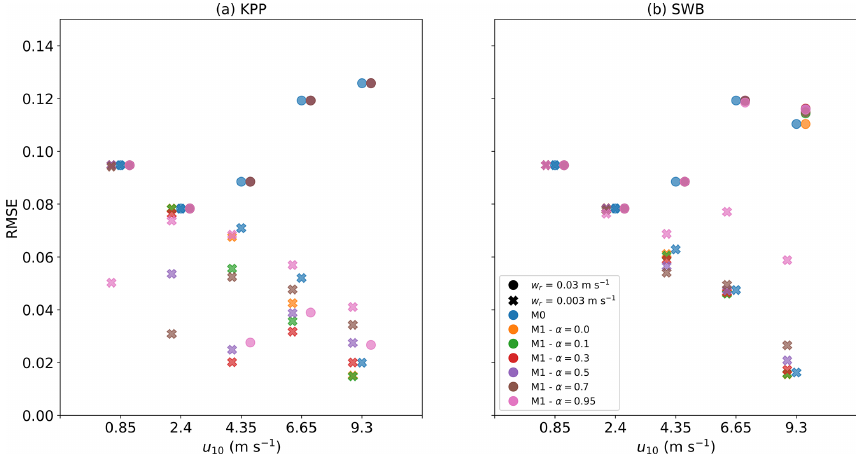
Figure 7. RMSE between field measurements and modeled concentration profiles for M-0 and M-1 models with (a) KPP and (b) SWB diffusion under different wind conditions and with varying values of α . All KPP diffusion simulations were with θ = 1 . 0 and z 0 according to Eq.